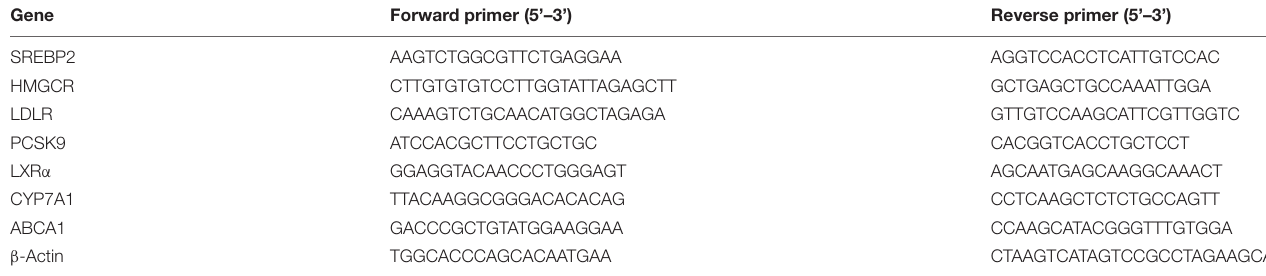
TABLE 1 | The primer sequences of related genes.